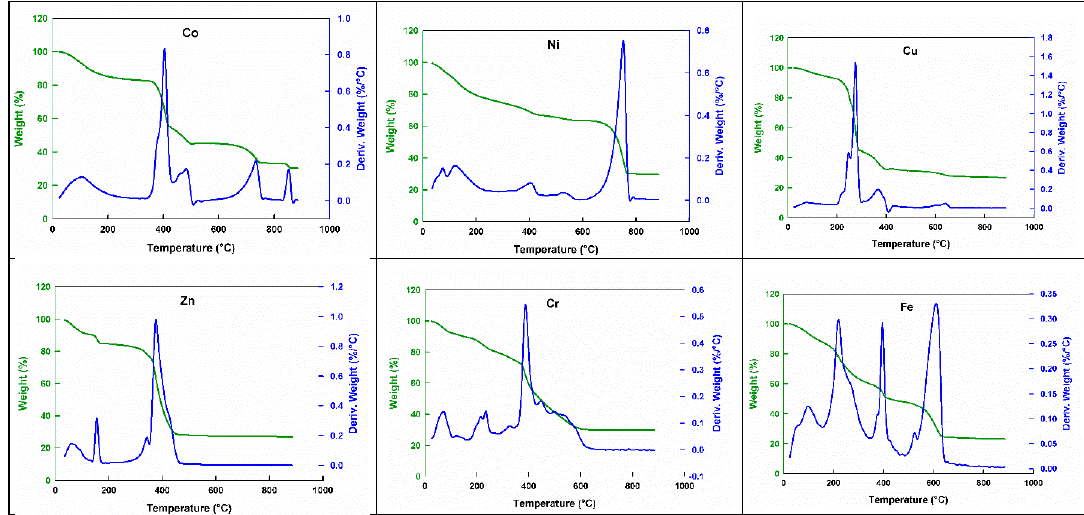
Figure 3 . The thermograms of the ternary metal coordinated oligomers . Figure 3. The thermograms of the ternary metal coordinated Table 4 . The values for the decomposition along with the species lost in each step .